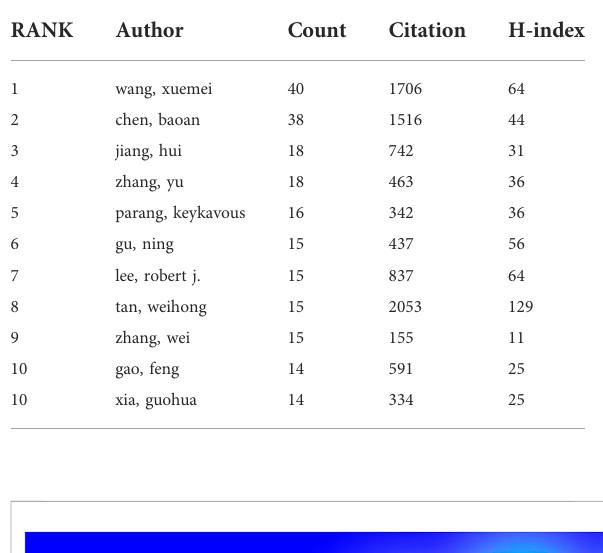
Frontiers in Bioengineering and